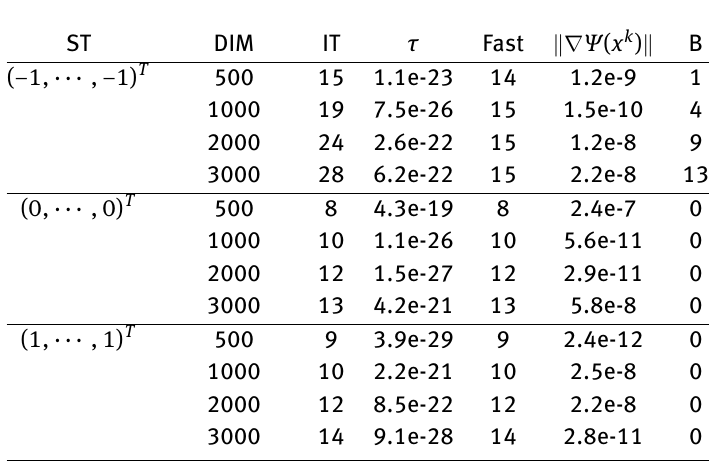
Table 4: Numerical results for Example 5.4 with θ = 1